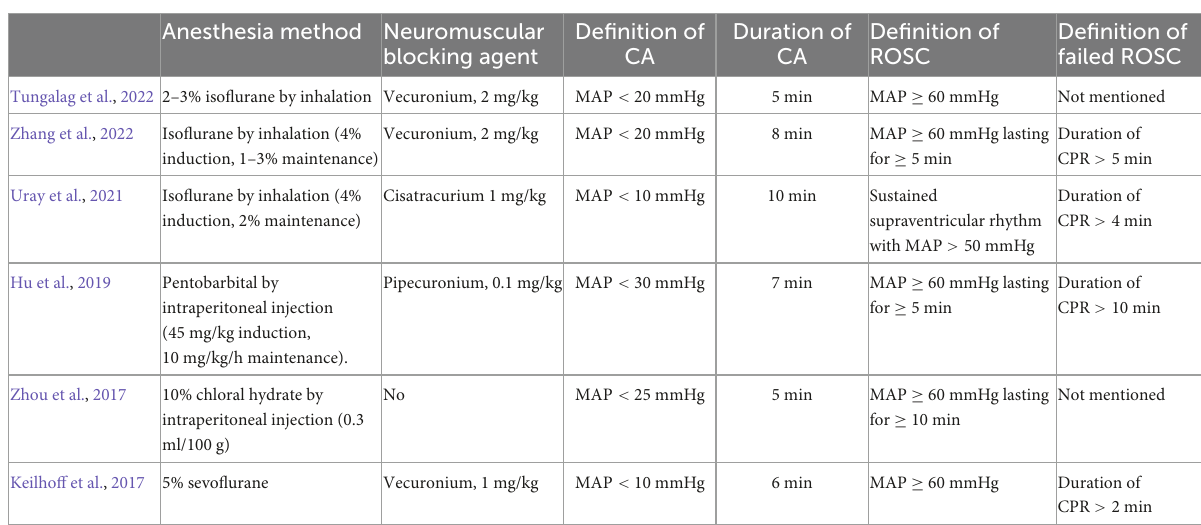
TABLE 2 Modeling factors to